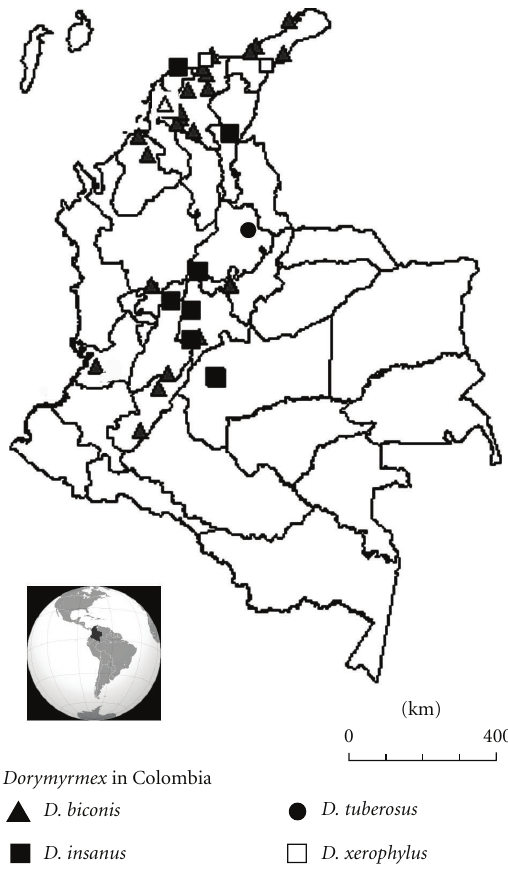
Figure 14: Geographic distribution of Dorymyrmex biconis , Dorymyrmex insanus , Dorymyrmex pyramicus, Dorymyrmex tubero- sus n. sp., and Dorymyrmex xerophylus n. sp. in